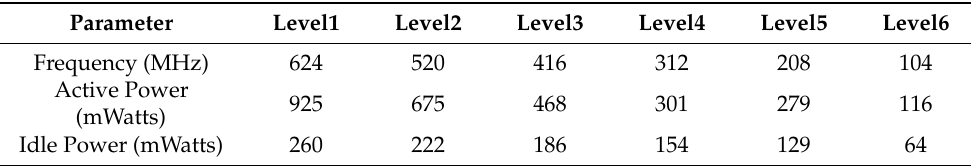
Table 1. Voltage-frequency levels of the PXA270 processor